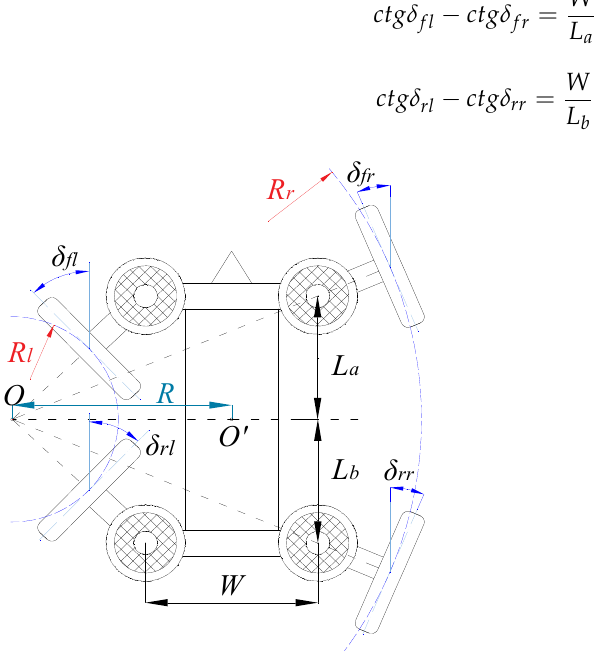
Figure 3. Illustration of the four-wheel-steering MMS for the robot chassis. O is the turning radius center; O ′ is the center of the chassis; R is the turning radius of chassis centroid (m); R l is the turning radius of the left wheels (m); R r is the turning radius of the right wheels (m); L a and L b denote the distances from the front and rear off-center axis to OO ′ , respectively (m); W is the distance between the left and right off-center axis (m); δ fl , δ fr , δ rl , δ rr denote the steering angles of the left front, right front, left rear and right rear wheel, respectively (rad).